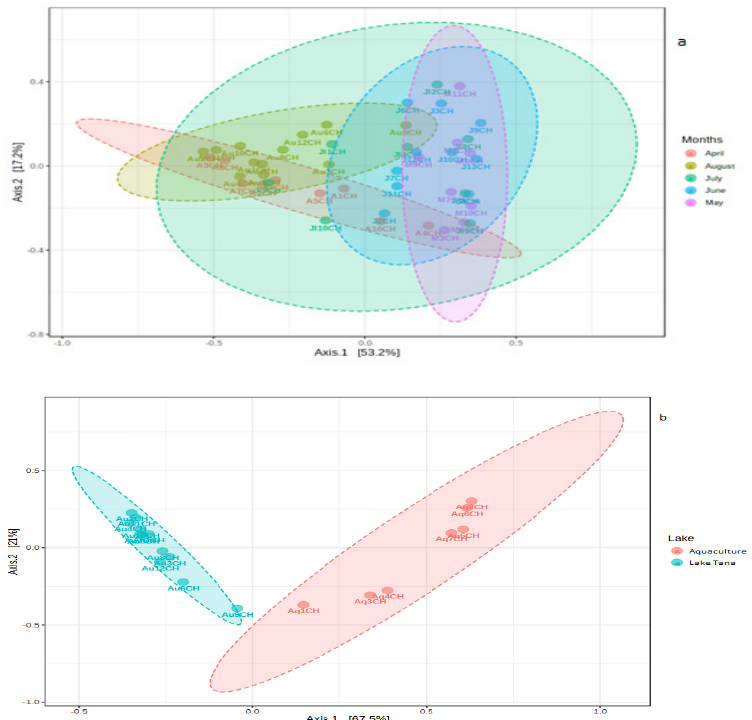
Figure 6. PCoA plot using Bray distance. The explained variances are shown in brackets. ( a ) PCoA plot for the Lake Tana samples based on the sampling months. ( b ) PCoA plot for the comparison of the Lake Tana and Bahir Dar aquaculture facility centre samples.